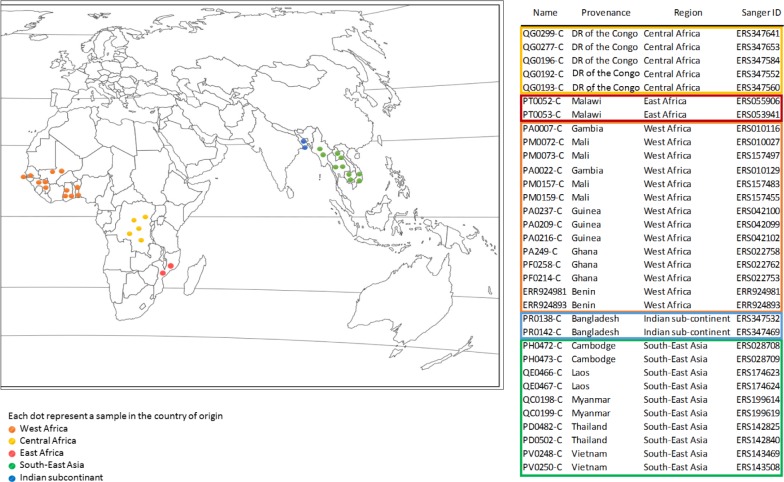
Geographic origin of the samples used for genomic studies of PFI1785w.